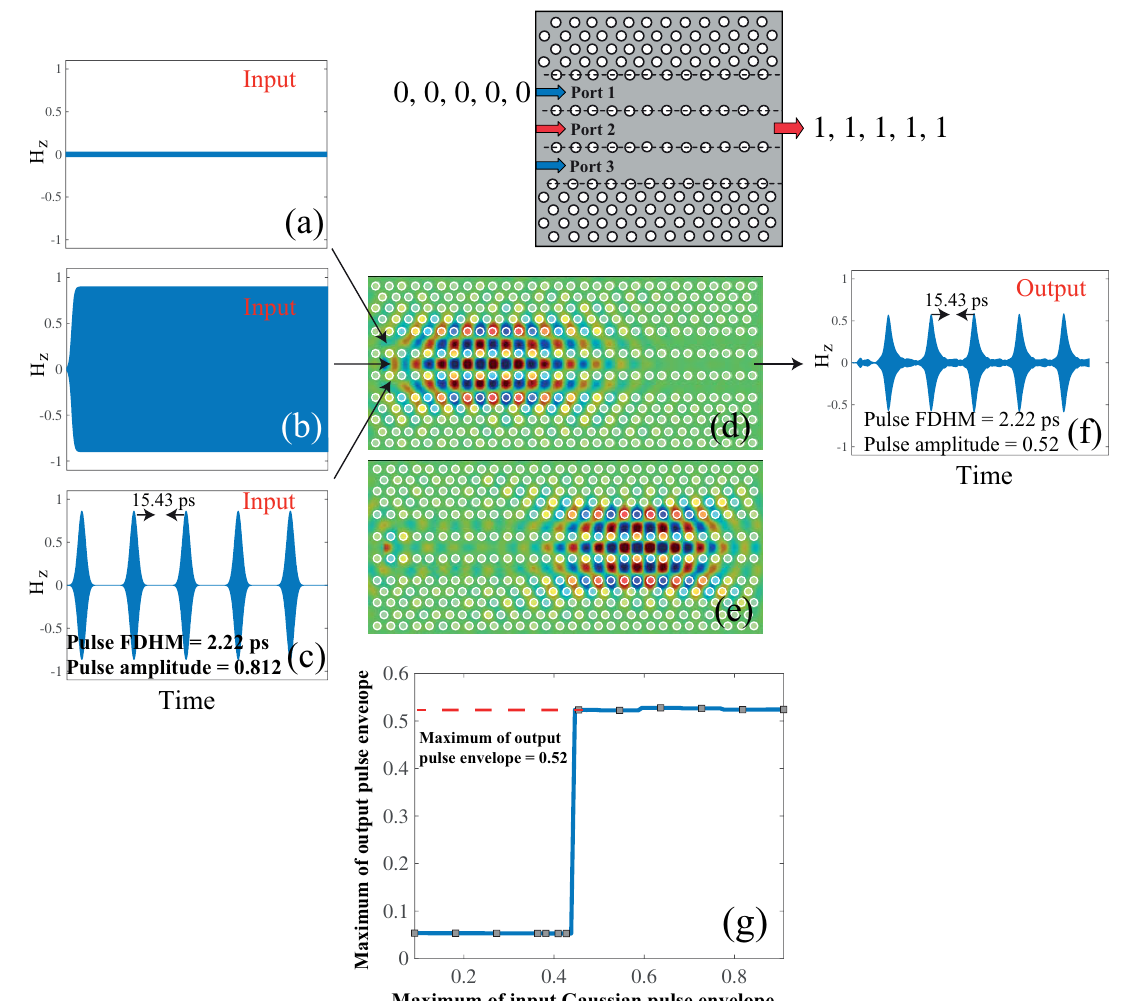
Figure 4. Results of simulations of all-optical NOT logic gate: in graphs ( a – c ), we demonstrate the injected signals: no signal into Port 1, a CW signal with amplitude A = 0.956 into Port 2 and a train of five Gaussian pulses with amplitudes A = 0.812, FDHM of 2.22 ps and a pulse repetition time of 15.43 ps into Port 3, respectively. In graphs ( d , e ), the magnetic field H z distributions of the band-gap soliton are illustrated and in graph ( f ) the magnetic field H z of the received signal at a distance x = 30 h is plotted. In graph ( g ), the dependence of the maximum of output pulse envelope versus the maximum of the input Gaussian pulse envelope is given. The peak level contrast between “1” and “0” is 20 dB. Reprinted from Ref.